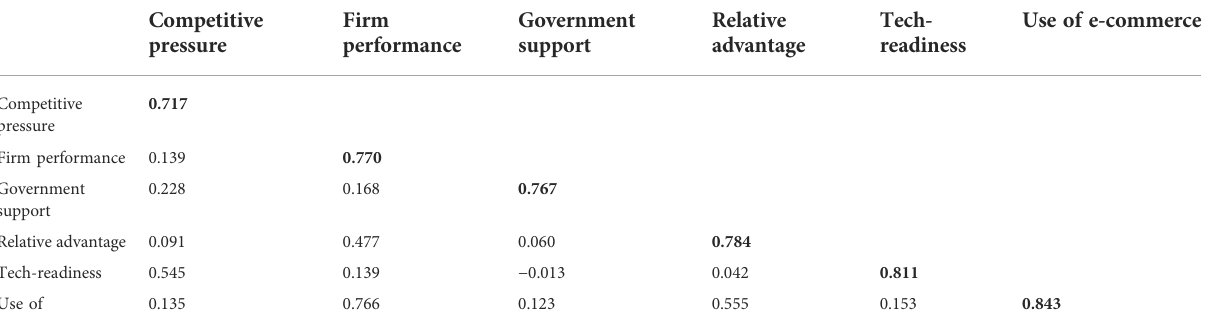
TABLE 5 Discriminate validity